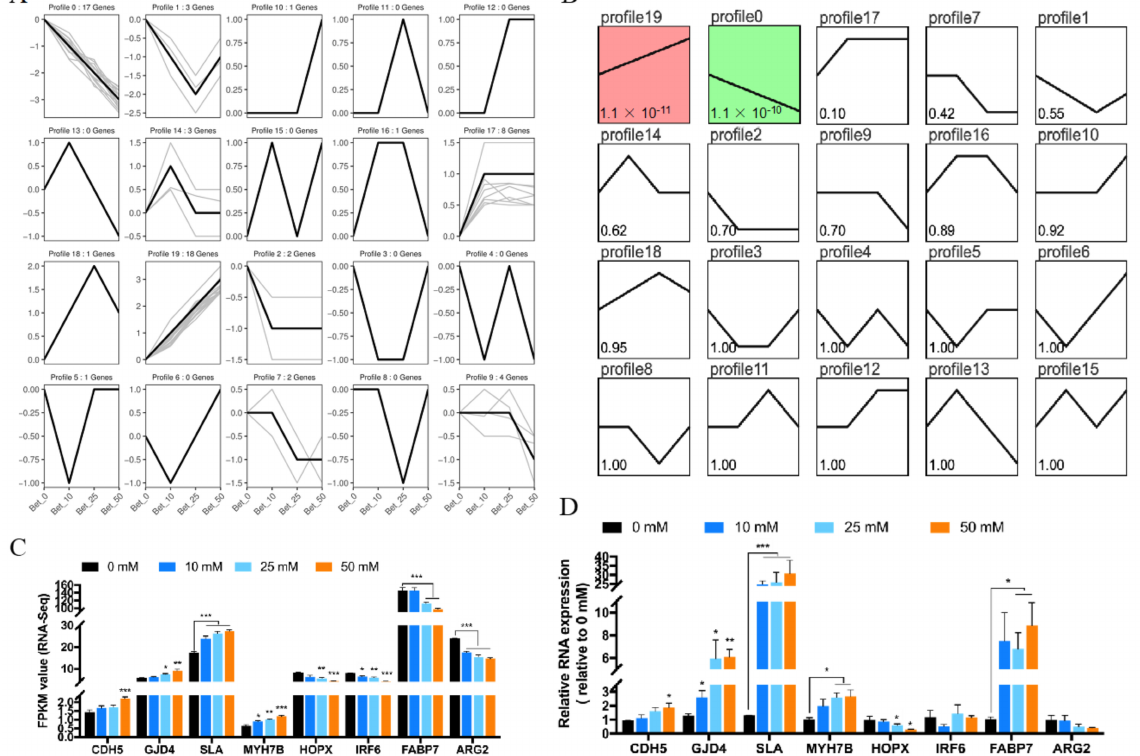
Figure 4. Gene expression pattern analysis of all DEGs. ( A ) General chart of all gene expression trend profiles. ( B ) Gene expression trend profiles are ordered based on the p -value significance of the number of genes assigned versus expected. ( C , D ) the FPKM value ( C ) and qRT-PCR validation ( D ) of eight DEGs in profile 0 and 19. (mM refers to mmol/L; * p < 0.05; ** p < 0.01; *** p <